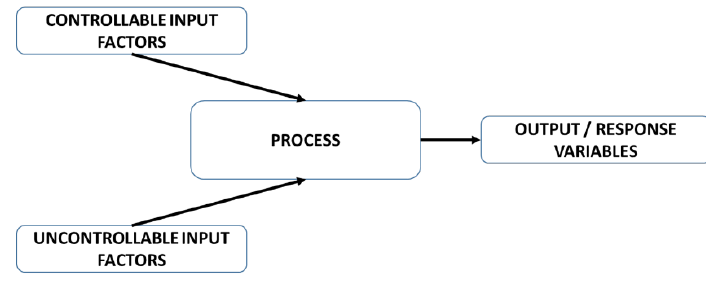
Figure 1. Experiment description.